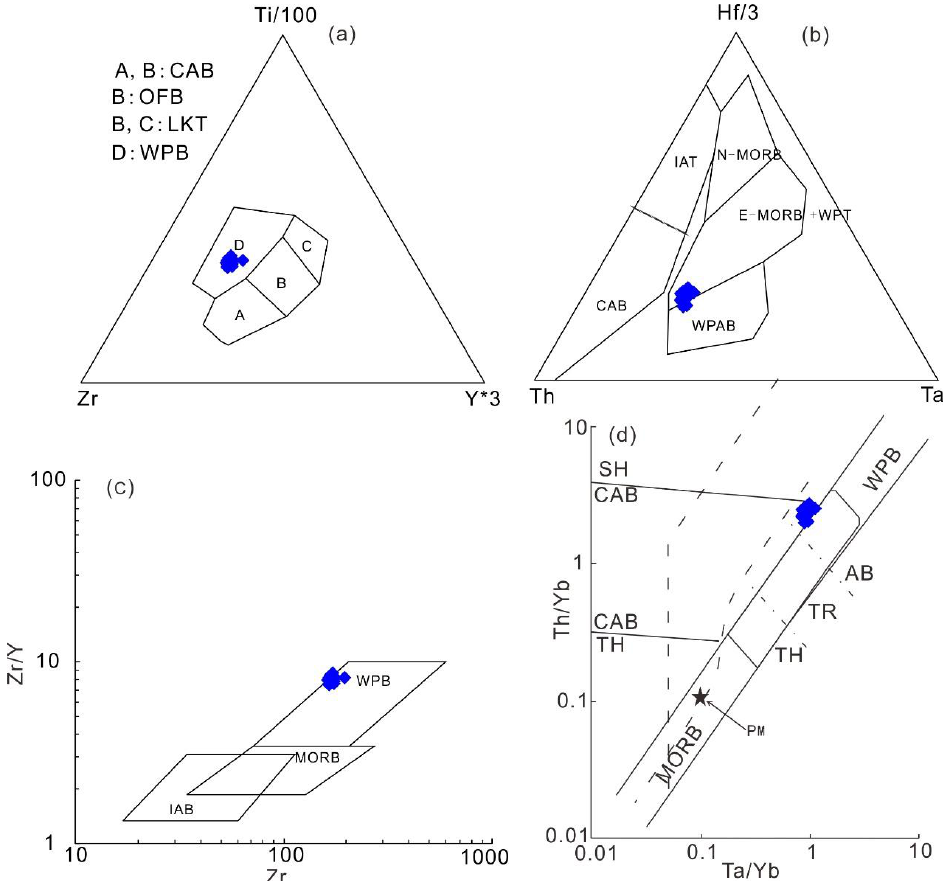
Figure 10. Tectonic environment discrimination diagrams for volcanic rocks from Jiangling Basin. ( a ) Diagram of Ti/1000 vs. Zr vs. Y × 3 (after [81]); ( b )diagram of Hf/3 vs. Th vs. Ta (after [80]); ( c ) diagram of Zr/Y vs. Zr (after [81]); ( d ) diagram of Th/Yb vs. Ta/Yb (after [80]). MORB/OIB mid-ocean ridge basalt/ocean island basalt; WPB-intraplate basalts; LKT-low-K arc tholeiite; CAB-calc-alkaline basalt; SH-mugearite; TH-tholeiite; TR-transition basalt; IAB/IAT-island-arc tholeiites; and PM-primitive mantle.